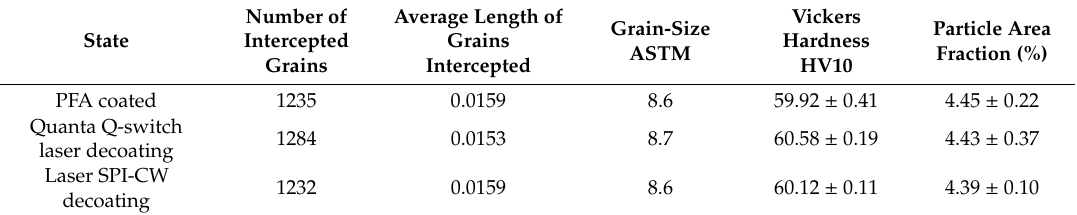
Table 6. ASTM grain size, Vickers hardness (HV), and % area of constituent particles of EN AW 5754 alloy in various states.